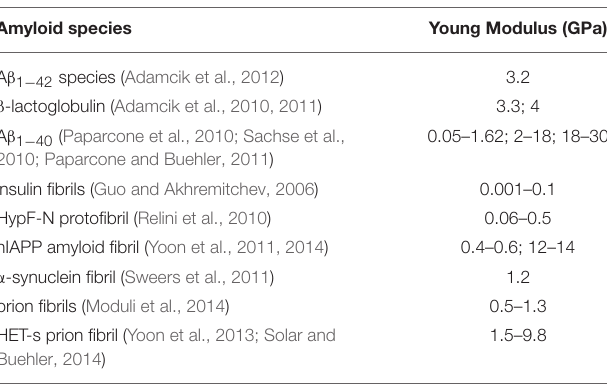
TABLE 1 | Young’s moduli of amyloidogenic peptides estimated in literature by previous computational or experimental studies. Amyloid